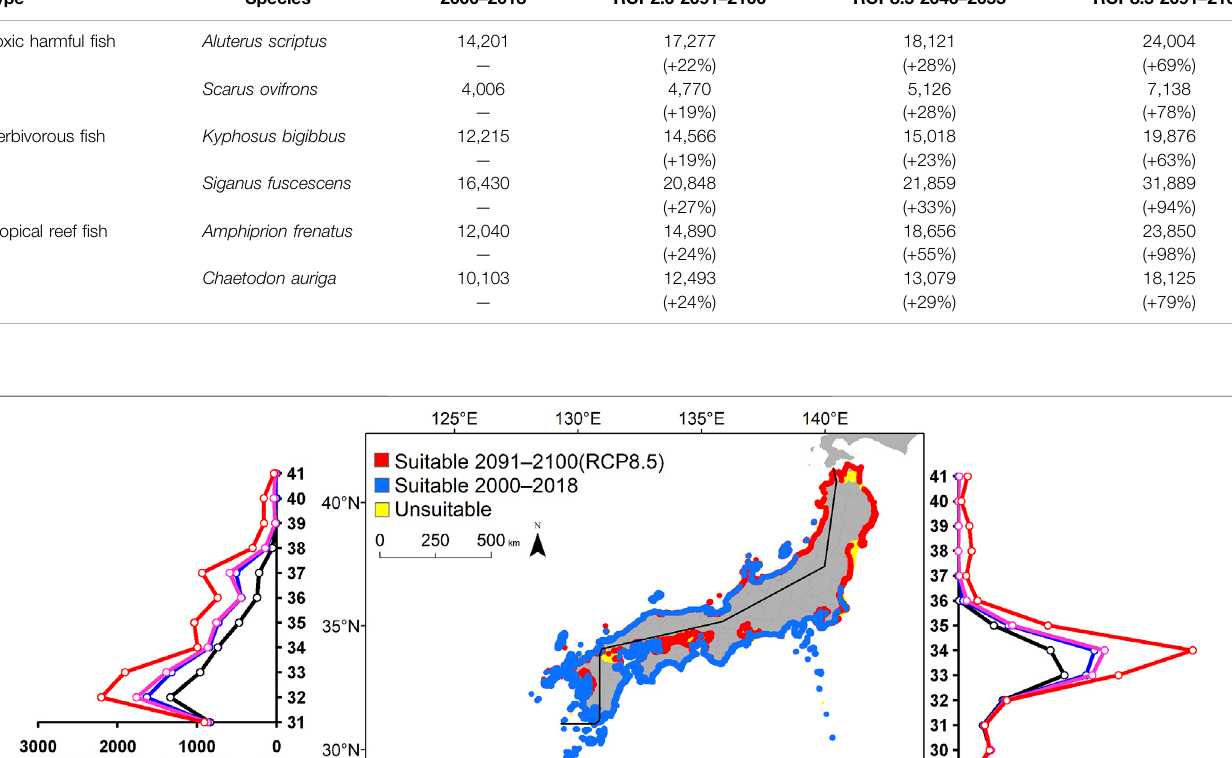
TABLE 3| Predicted number ofgrids forsix fi shspecies based ondifferentclimatescenarios.Thenumeralsintheparenthesisindicate percent changefrom the2000 – 2018 estimates. Type